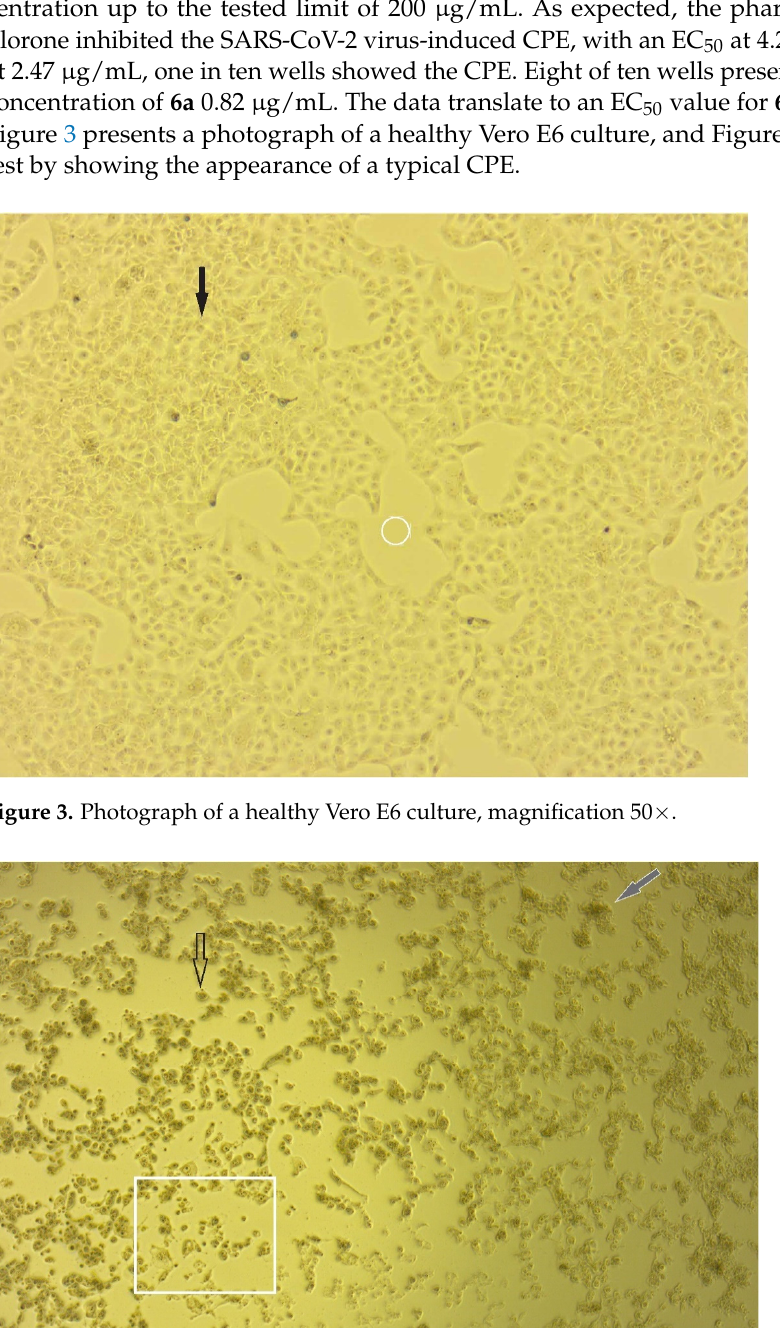
Figure 4. Photograph of an infected Vero E6 culture with typical signs of the virus-induced cytopathic effect, magnification 50×.